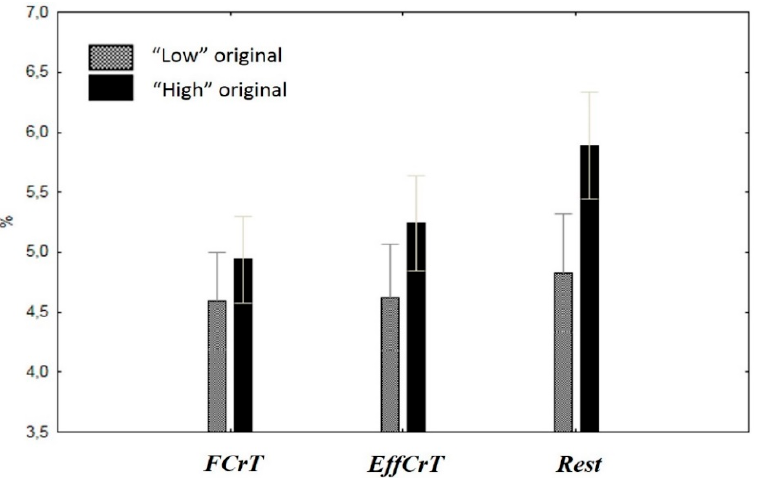
Figure 4. Between-group differences in terms of the 9–10Hz frequency percentage during task fulfillment.